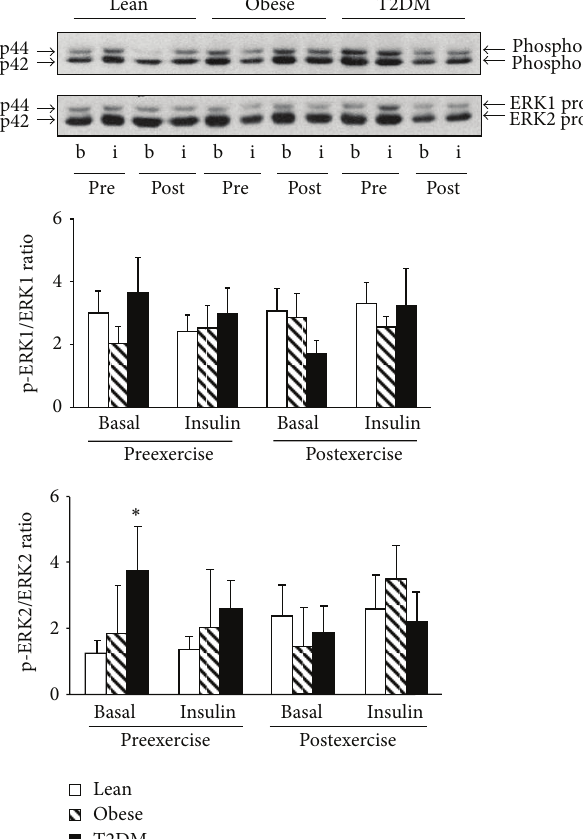
Figure 3: ERK phosphorylation and protein content. Phosphorylation of ERK 1 and 2 and ERK 1 and 2 protein was measured in PMNC from 17 lean, 8 obese, and 11 T2DM individuals at the basal state (b) and at the end of the insulin clamp (i) before (pre) and after (post) exercise training. Data are means ± SE. Blots are shown for one lean, one obese, and one T2DM individual. ∗ 𝑃 < 0.05 versus lean at basal preexercise training. a.u.: arbitrary